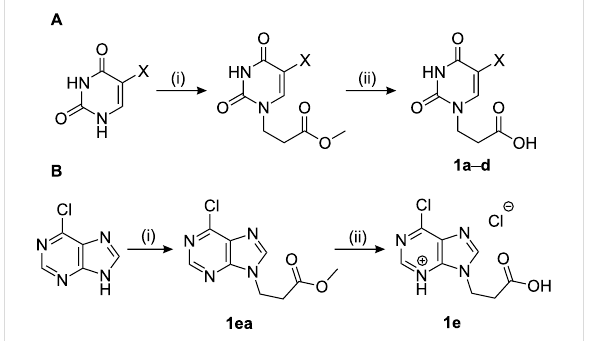
Compound II reduced the Plasmodium falciparum